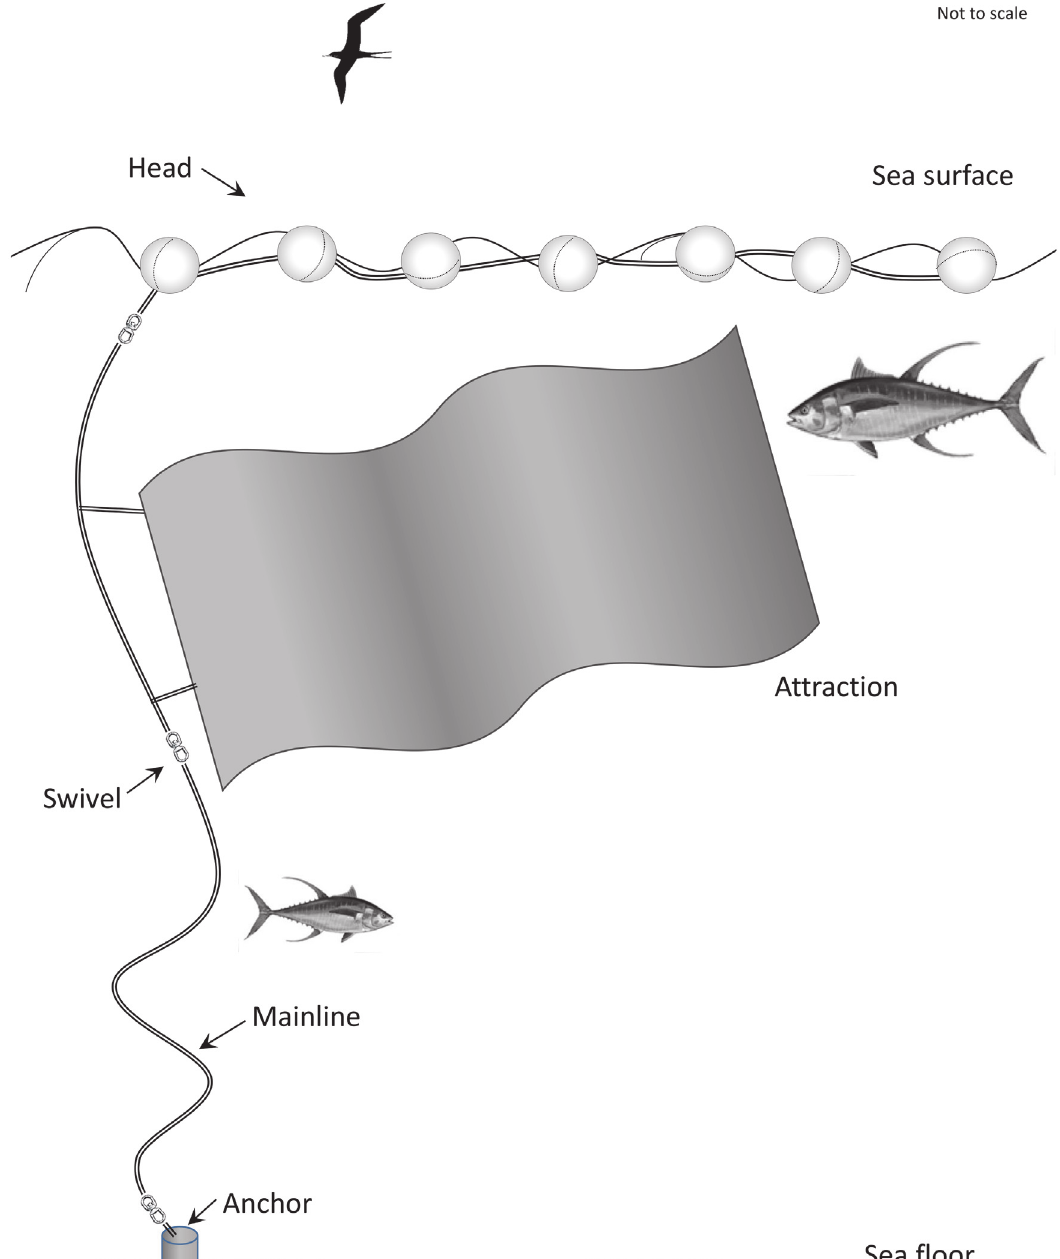
Fig 1. Schematic diagram of a typical FAD deployed from the field site. Designs vary around the island. The head consists of series of floats at the surface (~20cm – 40cm diameter) connected by rope or other material. The head can be 20m long. Referred to as attraction in Dominica, tarps and nets are attached near the surface in order to attract fish. Attraction is sometimes attached to the head as well to the top section of mainline as shown here. Metal swivels are placed at key points to allow the device to better withstand strong current and to act as weight to keep the rope from floating to the surface. A length of polypropylene rope is attached to an anchor made from half a 55 gallon drum filled with concrete. FADs are commonly placed at depths of 1000m – 2500m deep at distances of 15 – 50km from shore. The schematic is not to